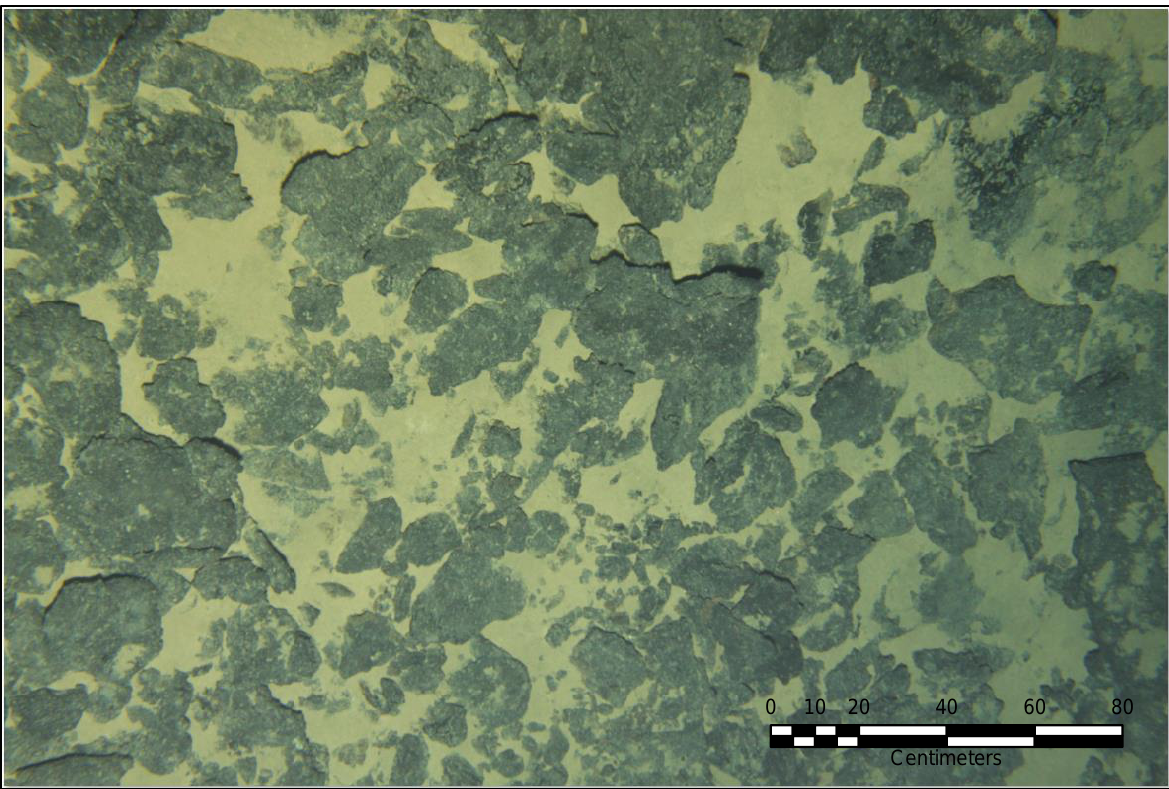
Figure 11. Sediment drift example photo. Source: TOML image 2015_08_10_225306.